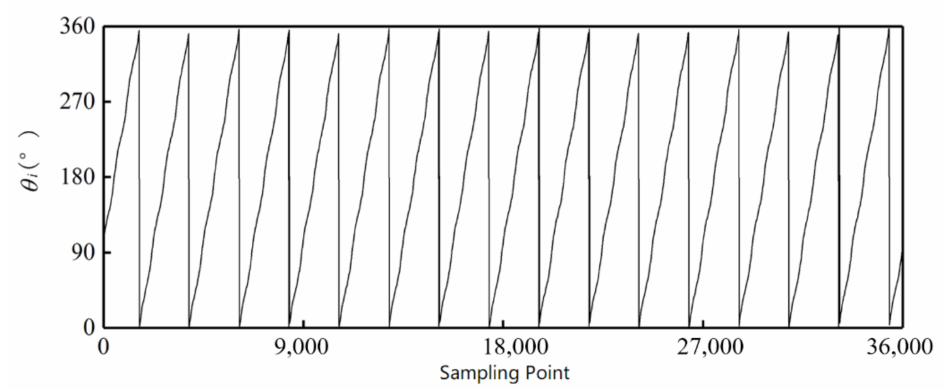
Figure 14. Decoding result for outer